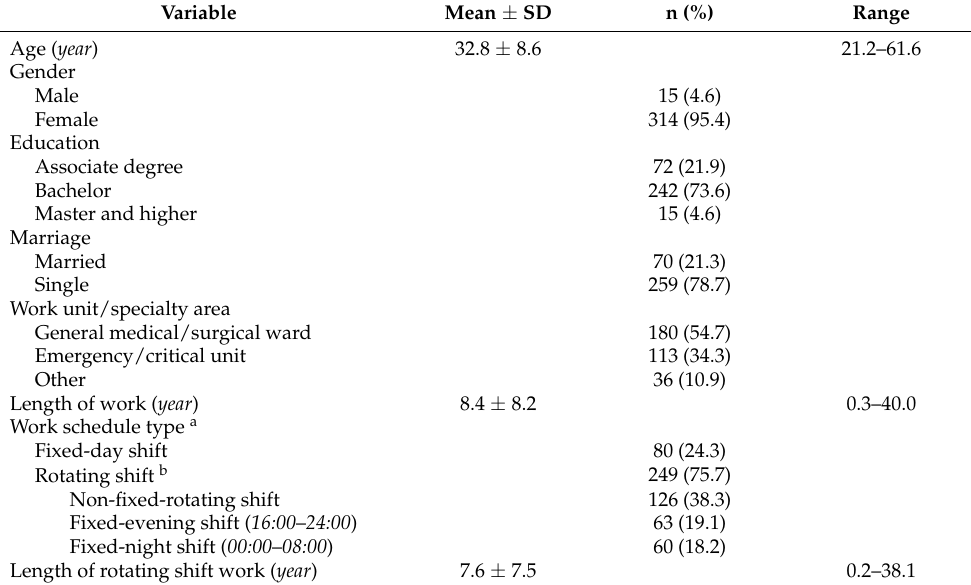
Table 1. Demographic and work schedule characteristics of the participants ( N =